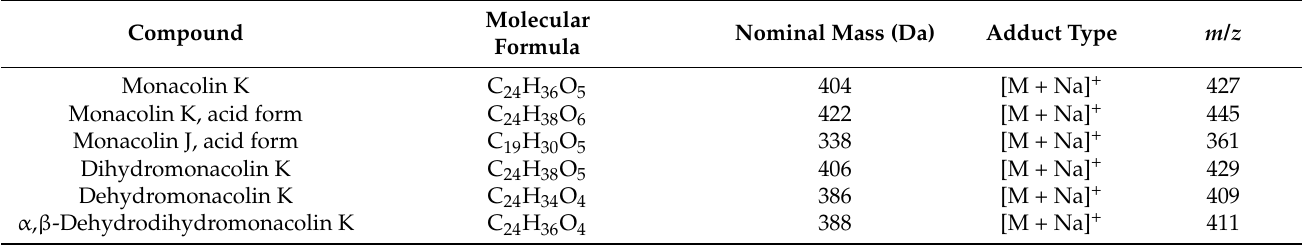
Table 4. Information about the molecular formula, nominal mass, adduct types and monitored m/z values for monacolins considered in this